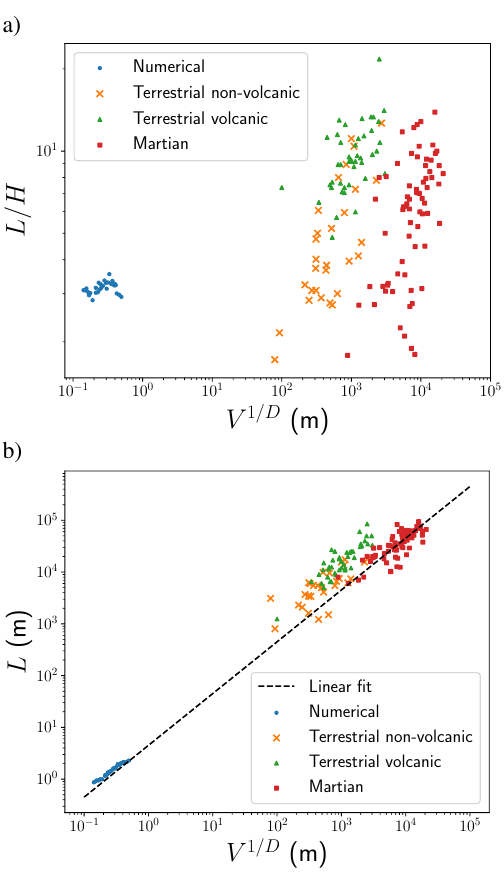
Figure 3. Data from geophysical events from Legros 2002 [9], and data points from the simulations from table 1, showing (a) = 1 /µ ef f = L / H and (b) the runout the e ↵ ective mobility M distance L as a function of the volume V 1 / D , where D = 2 for numerics and D = 3 for real